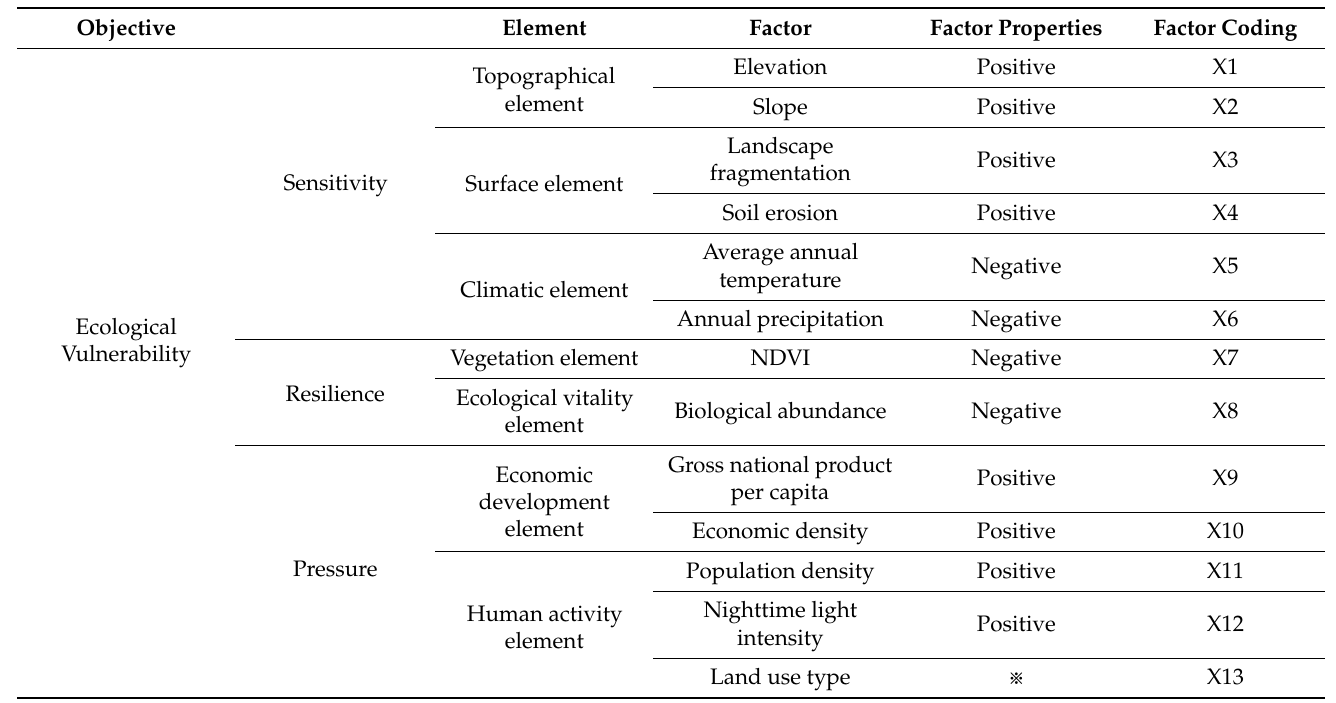
Table 1. Ecological vulnerability evaluation index system.